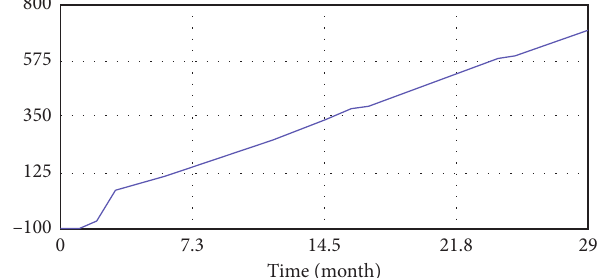
Figure 4: Project construction cost